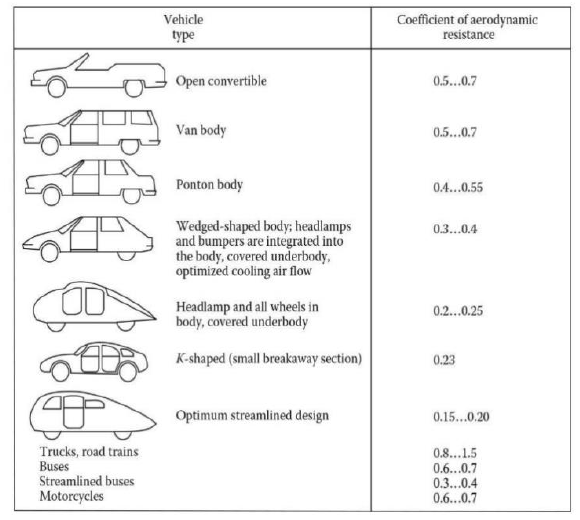
Fig. 5. Aerodynamic drag coefficient for different vehicle types